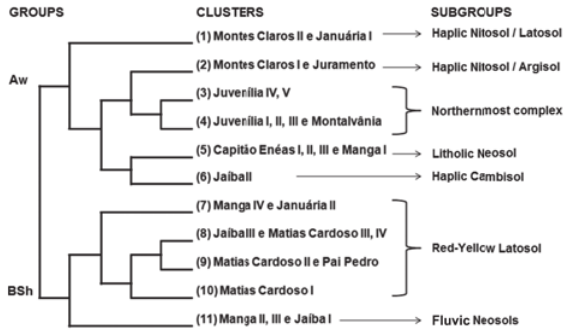
Figure 3 - Dendrogram of the relationships between 26 areas of dry forest sensu stricto (DF) in northern Minas Gerais as produced by the divisive clustering analyses of 396 species. The numbers in parentheses correspond to the clusters cited in the